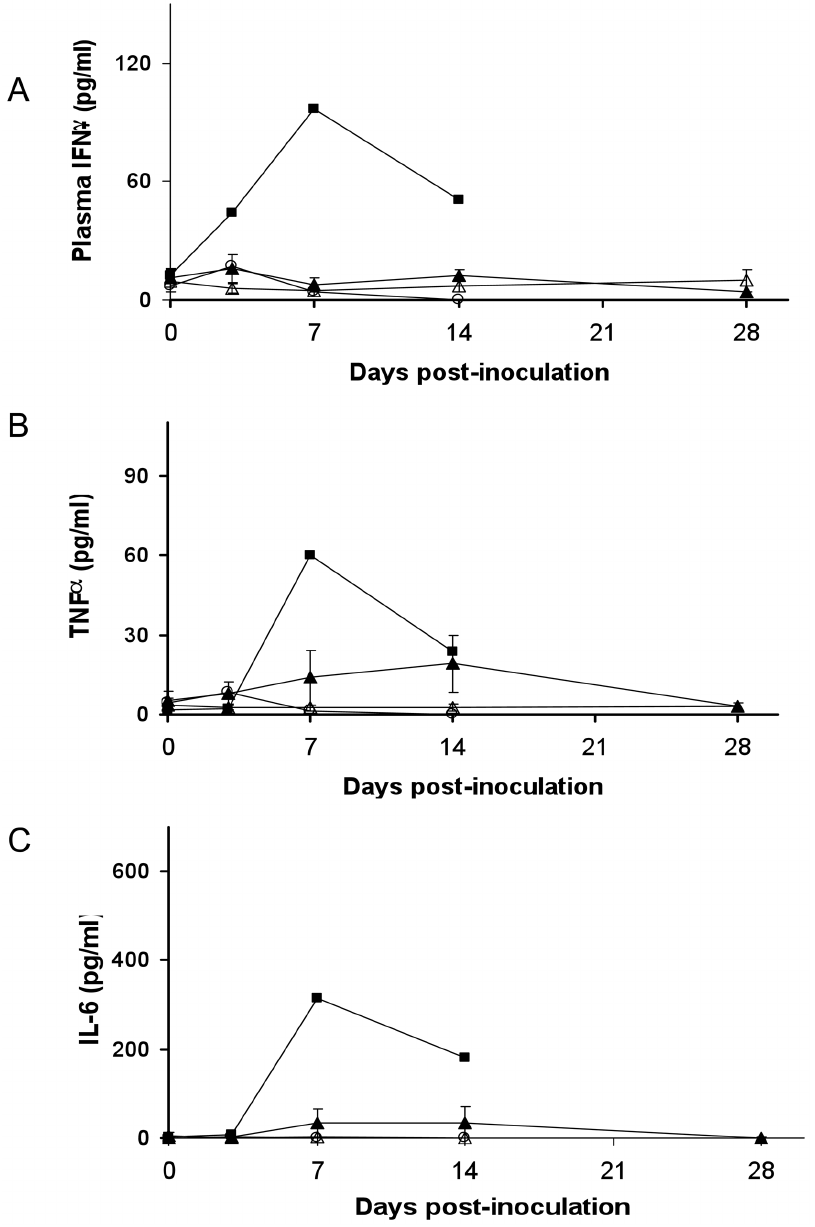
Figure 6. Plasma cytokine concentrations following intravenous inoculation with CVB3. Concentrations of single cytokines IFN-g (panel A), TNF-a (Panel B), and IL-6 (panel C) are demonstrated. Mean cytokine concentrations for the two animals receiving high dose (10 7 pfu) CVB-H3 by i.v. ( & ) or the single animal infected by enteral infection ( # ) are shown. Mean cytokine concentration + / 2 SEM for animals receiving low dose (10 6 pfu) CVB-H3 ( m ) or CVB-MCH ( D ) by i.v. are